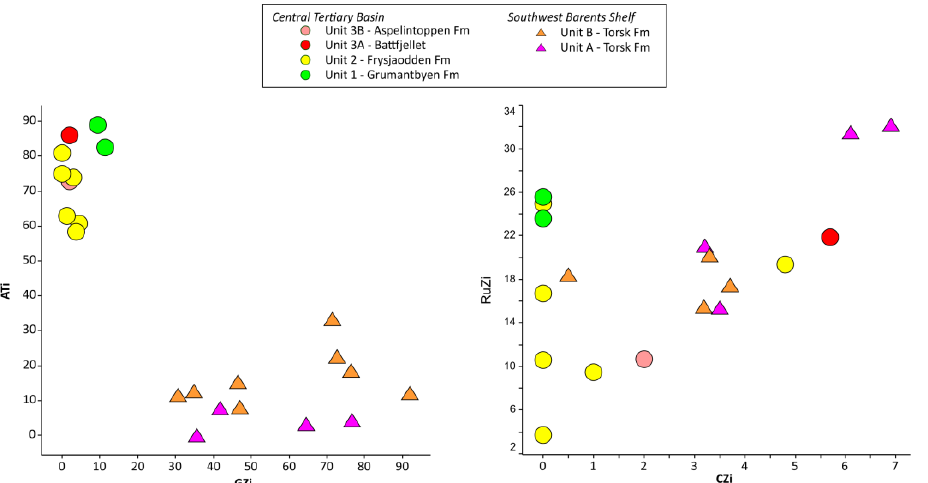
Figure 5. Cross-plots of provenance sensitive heavy mineral indices, after Morton and Hallsworth [54] for the investigated samples. ATi = Apatite-tourmaline index, CZi = chrome spinel-zircon index, GZi = garnet-zircon index, RuZi = rutile-zircon index.